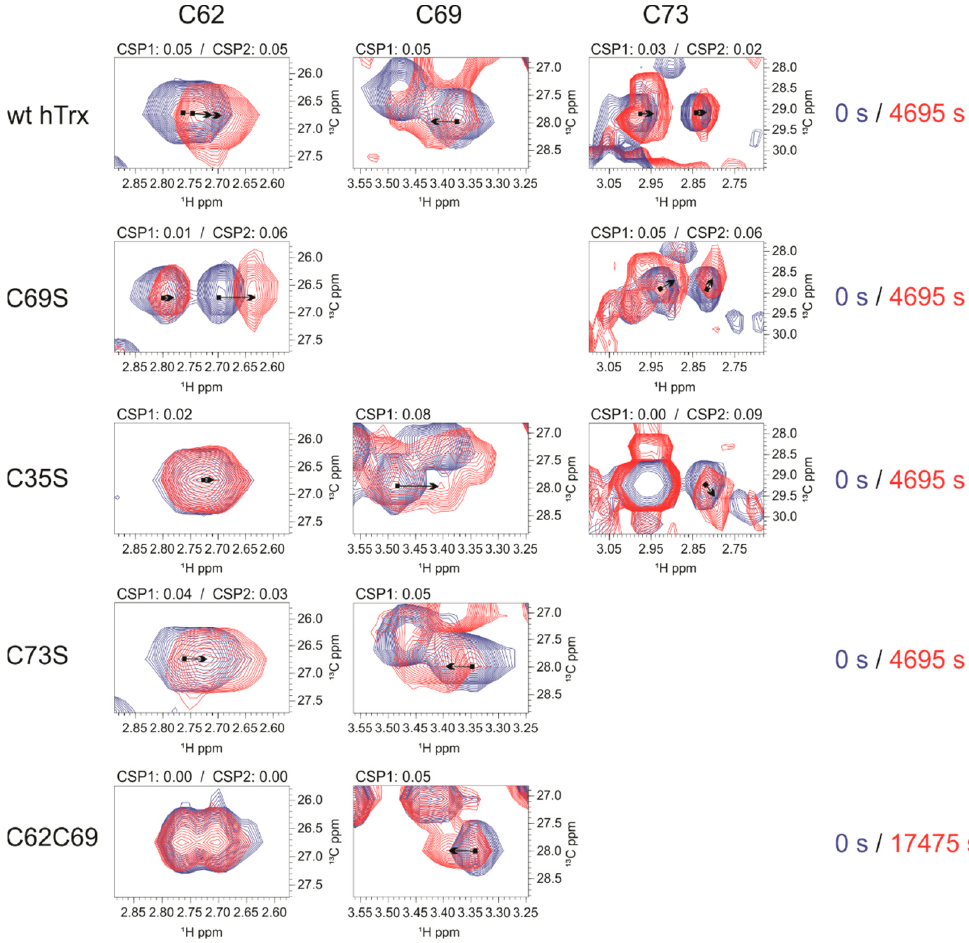
Figure 6. 1 H β - 13 C β CSP of C62, C69, and C73 residues to hTrx and varied mutants. Blue 1 H- 13 C HSQC corresponds to time zero, before GSNO addition, and the red one represents a reaction time after GSNO addition. The data show remarkably CSP to C62 to hTrx, C69S and C73S mutants, and a small CSP to C35S mutant. C62 residue did not change to C62C69. The results suggest that oxidation of the redox site affects the residue C62, S-nitrosation of C73 is less important to C62 CSP and C69 S-nitrosation does not affect C62. Concerning C69, all mutants and hTrx showed a noteworthy CSP, that is not related to either oxidation of the redox site or C73 S-nitrosation , but C62 S-nitrosation . In the same way, C73 is affected by C62 S-nitrosation .